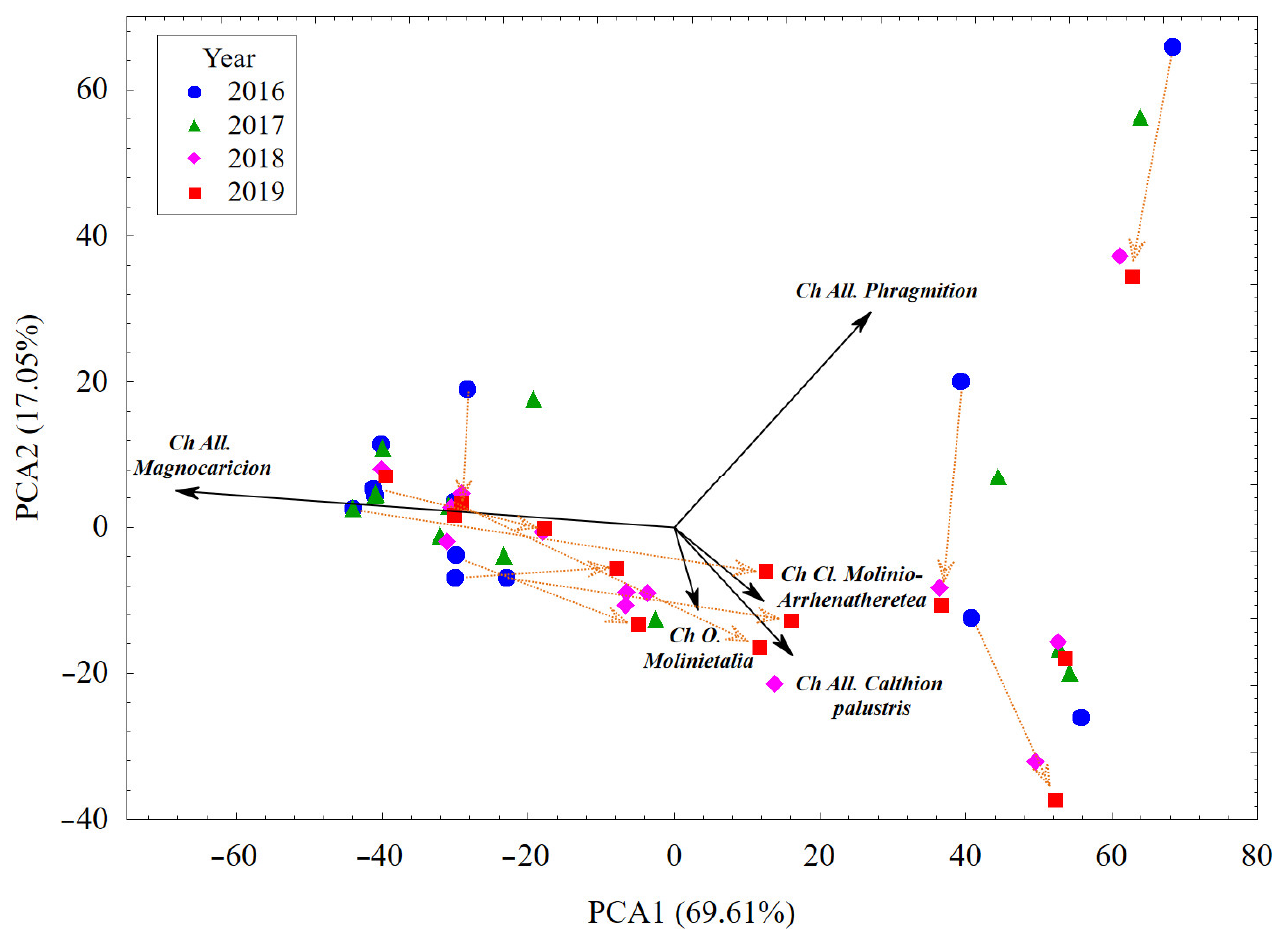
Figure 2. The PCA analysis scaled scatter plot of phytosociological relevés according to cover abundance of the characteristic species. Black solid vectors show the contribution of the individual species in the values of the principal components, while the orange dotted line vectors represent the trend of changes in the species cover for the particular phytosociological relevés in 2016–2019.